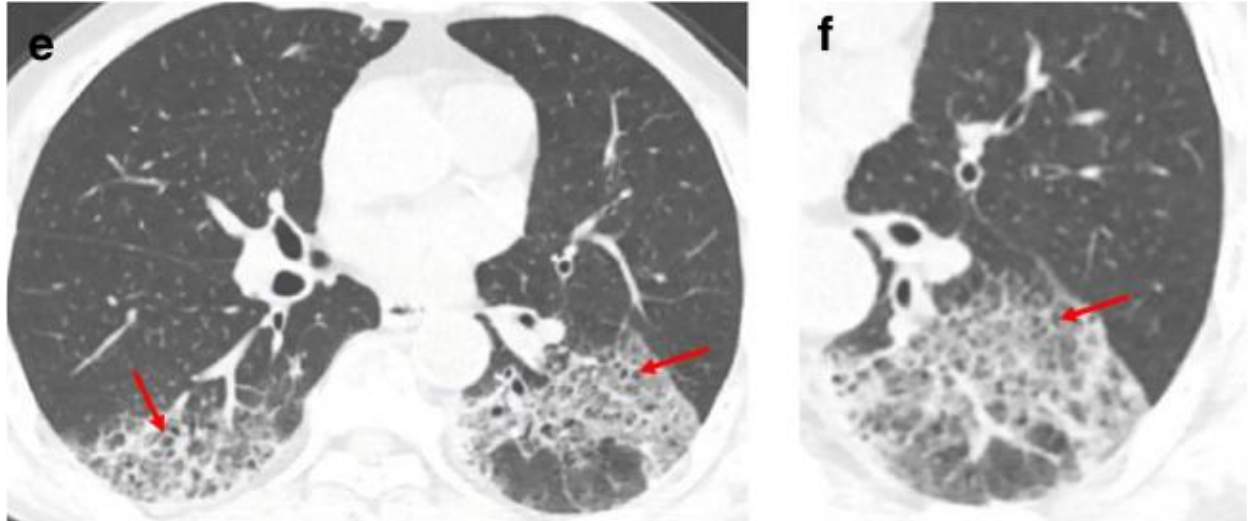
Figure 7: Courtesy reference number 40. A 62-year-old man with a history of exposure to a market in Guangzhou presented with fever and cough for 11 days. Non-contrast enhanced chest CT showed multiple ground glass opacification in the both lower lobes and thickening of the adjacent pleura (e, f). Red arrows represent the interlobular septal thickening in regions of ground glass opacification (crazy paving